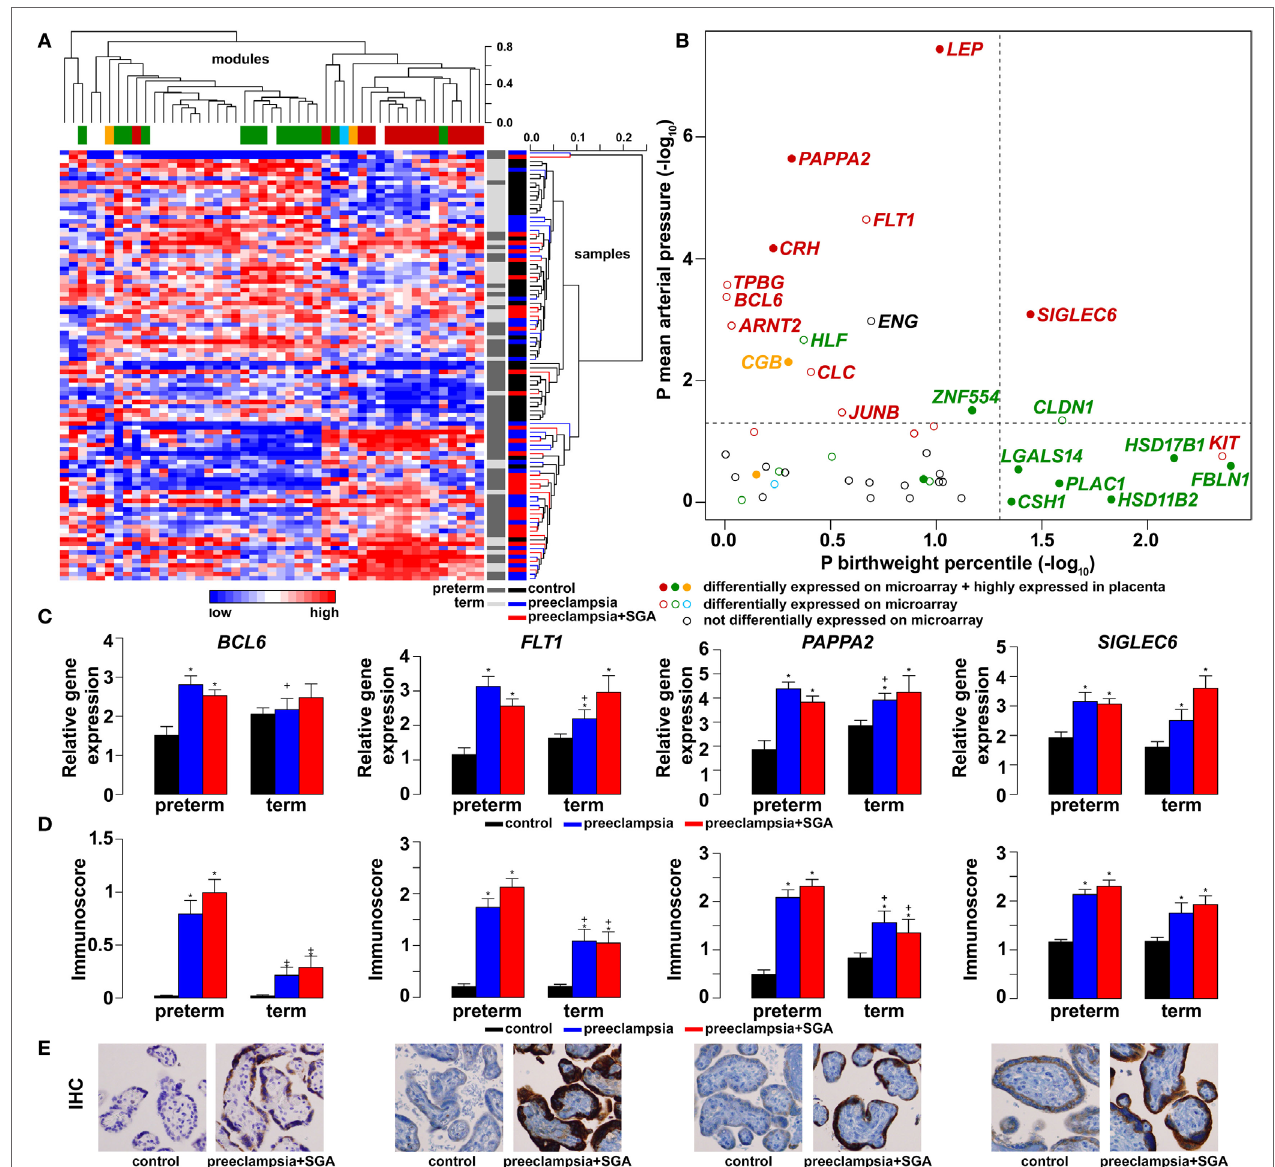
FigUre 4 | Gene modules associated with blood pressure (BP) and birthweight (BW). (a) Hierarchical clustering of qRT-PCR data obtained with 100 samples and 47 genes. Pearson correlation was used for similarity analysis and average method for linkage calculation. Samples were colored according to patient groups and maturity status. M1 (green) and M2 (red) module genes and 34 of 60 samples from women with preeclampsia clustered together. (B) Association of gene expression with BP and BW. The significance p -values for these coefficients were plotted for all genes, colored according to module classification (black: not changed on the microarray). Filled circles represent predominantly placenta-expressed genes and dashed lines the significance threshold at p = 0.05. Seven of 9 genes related to BW belong to module M1, while 10 of 15 genes related to BP are from module M2. Gene expression (c) and protein immunostaining (D) of selected four genes in module M2 show similar patterns in the sub-groups of preeclampsia, and semi-quantitative immunoscorings validate gene expression data. Significant differences in preterm or term preeclampsia samples compared to gestational-age matched controls are shown with “*”. When the change with preeclampsia in preterm samples was different from that in term samples, a “ + ” marks such an interaction. Comparisons for all genes are available in Figure S3 in Supplementary Material. (e) Representative images of the same placenta from a preterm control (left, 29 weeks) and a patient with preterm preeclampsia associated with SGA (right, 31 weeks) are shown for the immunostainings (hematoxylin counterstaining, 40 ×